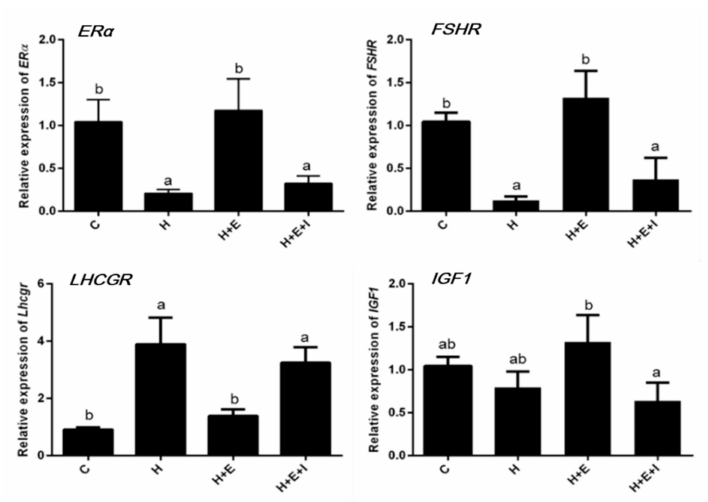
Figure 1. E ff ects of hypoxia on relative expression of ER α , FSHR , LHCGR , and IGF1 genes in bovine follicles. C, Control; H, Hypoxia; H + E, Hypoxia with E 2 ; and H + E + I, Hypoxia with E 2 and ICI. Di ff erent letters (a,b) on the bar means significant di ff erences ( p < 0.05).